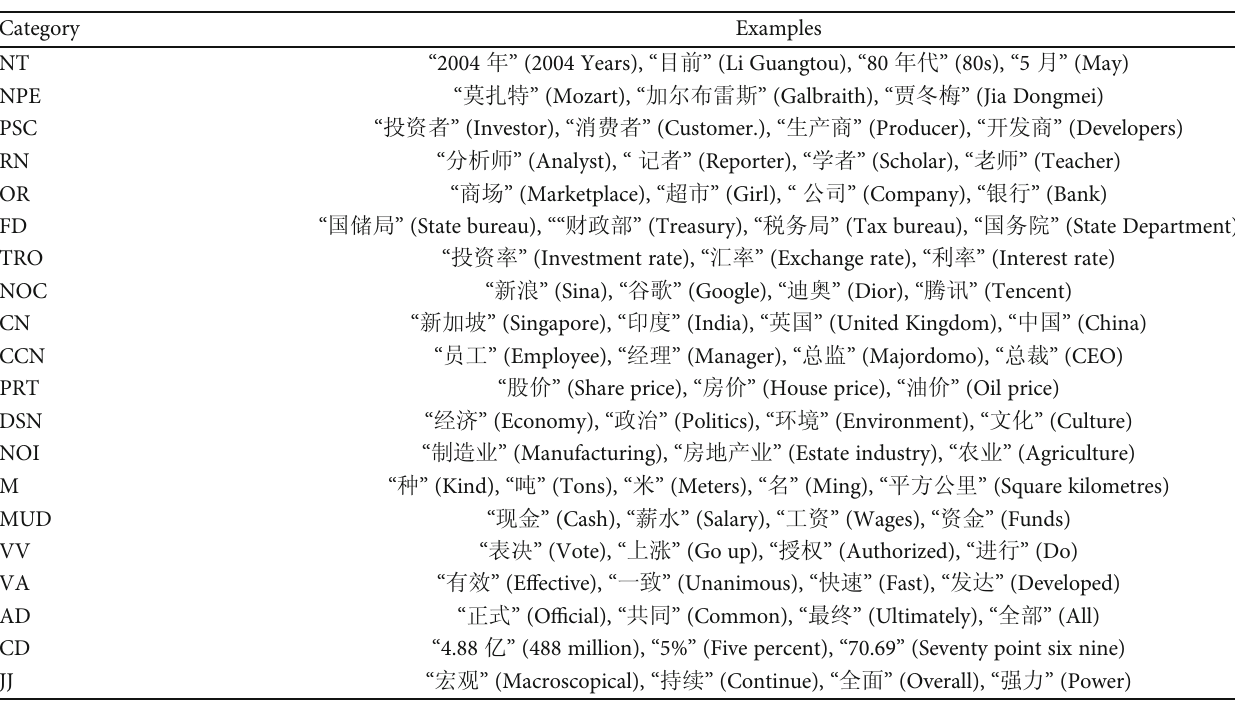
Table 6: News keyword list